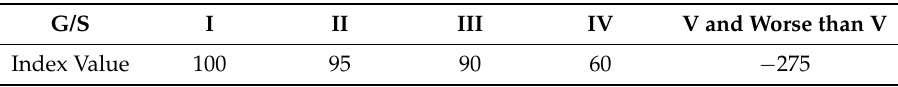
Table 6. Groundwater quality ( G ) and surface water quality ( S ) scoring